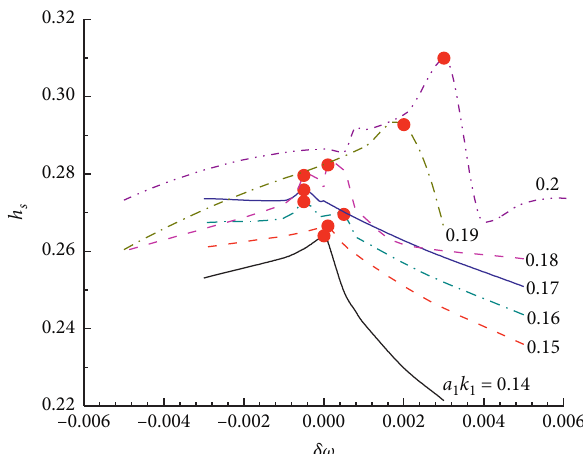
Figure 4: Wave steepness ( h resonant wave system in the case of k α � 3 π